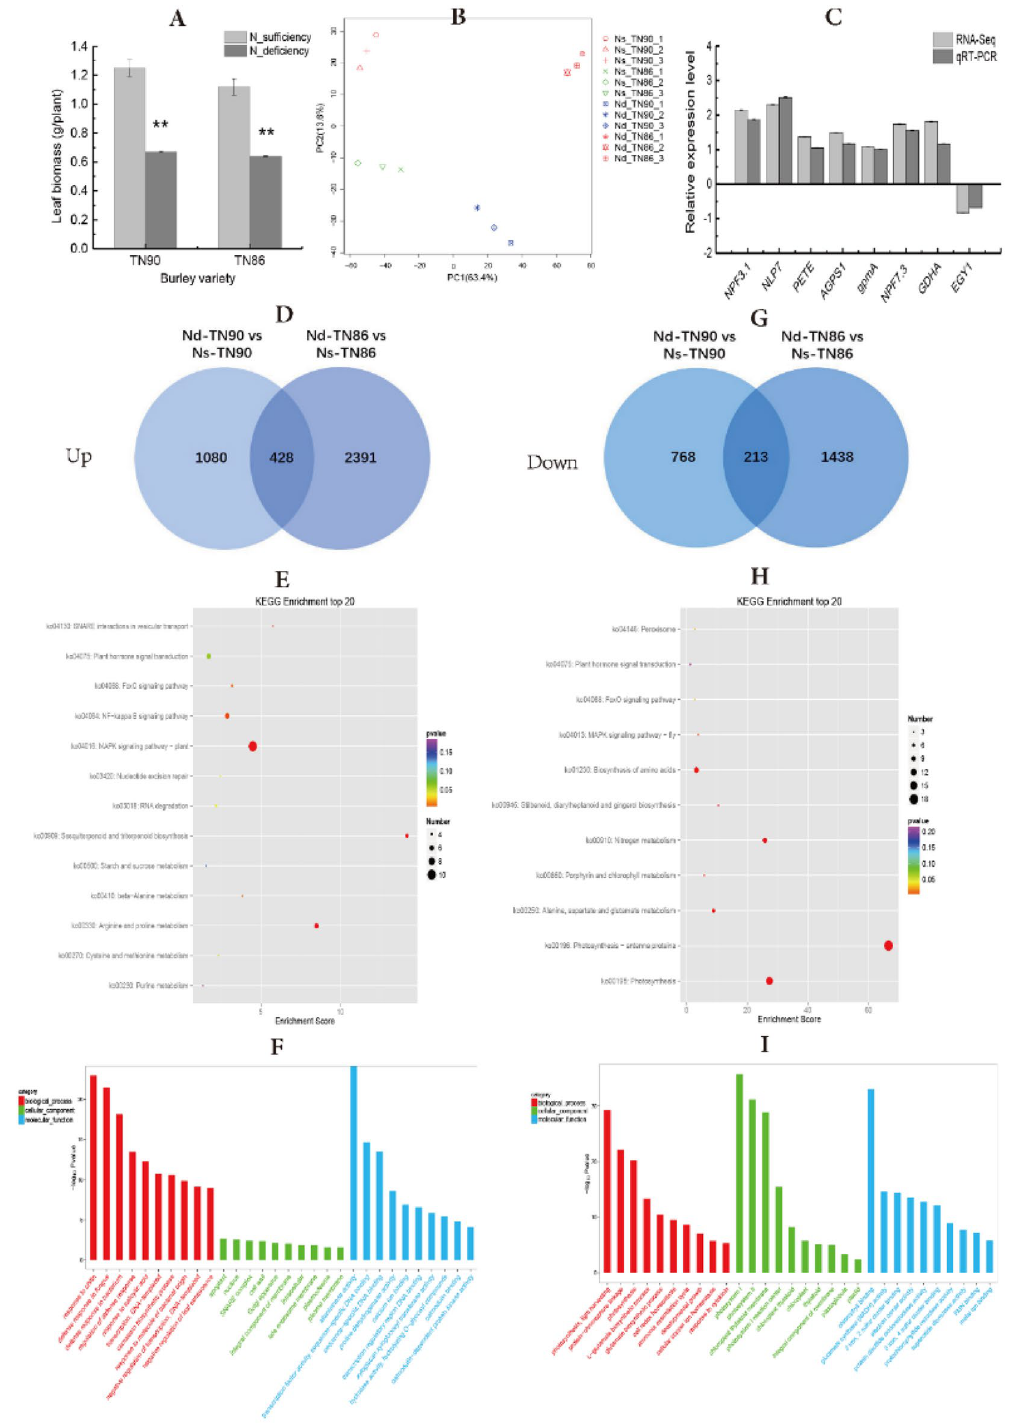
Figure 1. RNA-Seq analysis of burley tobacco response to nitrogen deficiency. ( A ) Leaf biomass; ( B ) PCA; ( C ) RNA-Seq results confirmed by quantitative qRT-PCR; ( D ) Venn diagram of upregulated DEGs under nitrogen-deficient conditions vs nitrogen-sufficient conditions in burley tobacco varieties TN90 and TN86; ( E ) KEGG enrichment in common upregulated DEGs in TN90 and TN86; ( F ) GO enrichment in common upregulated DEGs in TN90 and TN86; ( G ) Venn diagram of downregulated DEGs under nitrogen-deficient conditions vs nitrogen-sufficient conditions in TN90 and TN86; ( H ) KEGG enrichment in common downregulated DEGs in TN90 and TN86; ( I ) GO enrichment in common downregulated DEGs in TN90 and TN86. Nd-TN90 TN90 cultivated under nitrogen-deficient conditions, Ns-TN90 TN90 cultivated under nitrogen- sufficient conditions, Nd-TN86 TN86 cultivated under nitrogen-deficient conditions, Ns-TN86 TN86 cultivated under nitrogen-sufficient conditions. Error bars of leaf biomass indicate standard error of the means (n = 3). Error bars of qRT-PCR indicate standard error of the means (n = 6). Symbol ** indicates a statistically significant differences between the nitrogen- deficient and nitrogen-sufficient nitrogen at p <